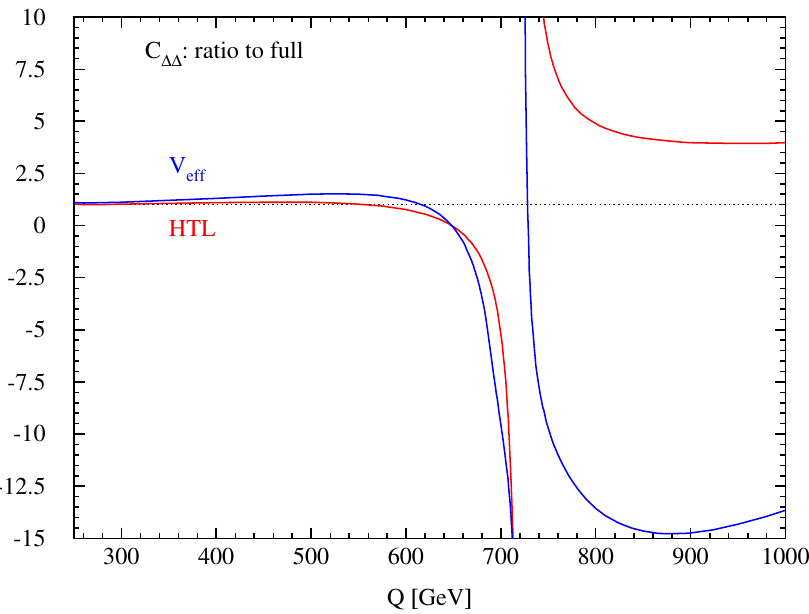
Figure 4 . Comparison of the approximation of ref. [73] (blue) for the one-particle-reducible contributions and the HTL (red), both normalized to the full analytical expression. The singularity at about 720 GeV is due to a sign change of the exact